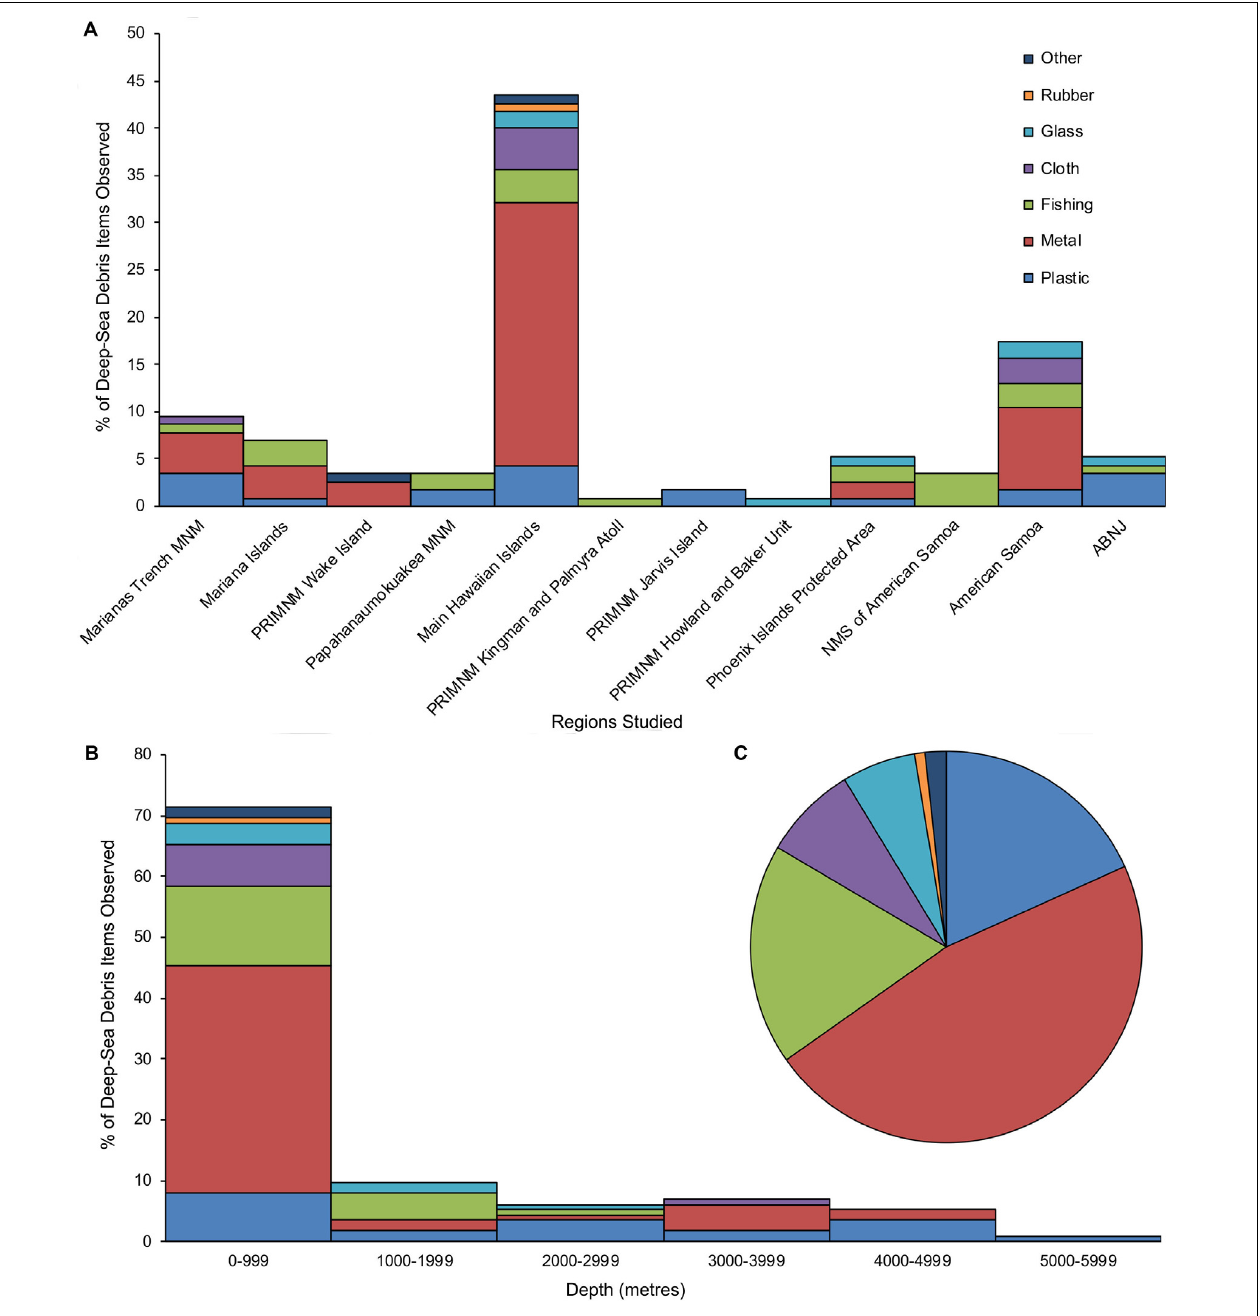
FIGURE 3 | Percentage types of deep-sea debris items observed (A) by region; (B) by depth; and (C) overall. No debris observations were made in PRIMNM Johnston Atoll, Rose Atoll Marine National Monument, and Tokelau. MNM, Marine National Monument; PRIMNM, Pacific Remote Islands Marine National Monument; NMS, National Marine